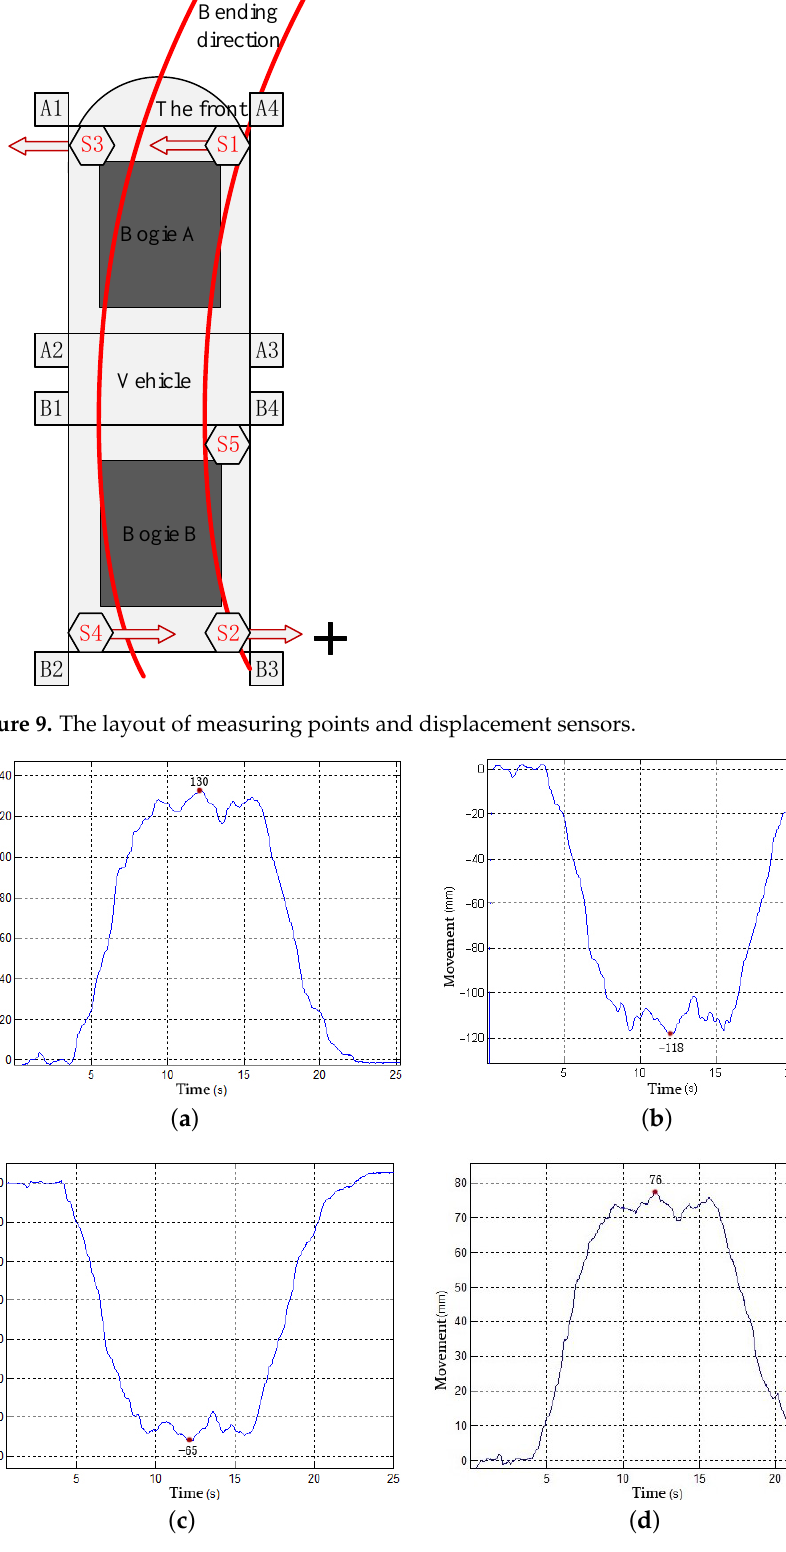
Figure 10. Test results. ( a ) Displacement curve of sliding table at A1; ( b ) displacement curve of sliding table at A4; ( c ) displacement curve of sliding table at B2; ( d ) displacement curve of sliding table at